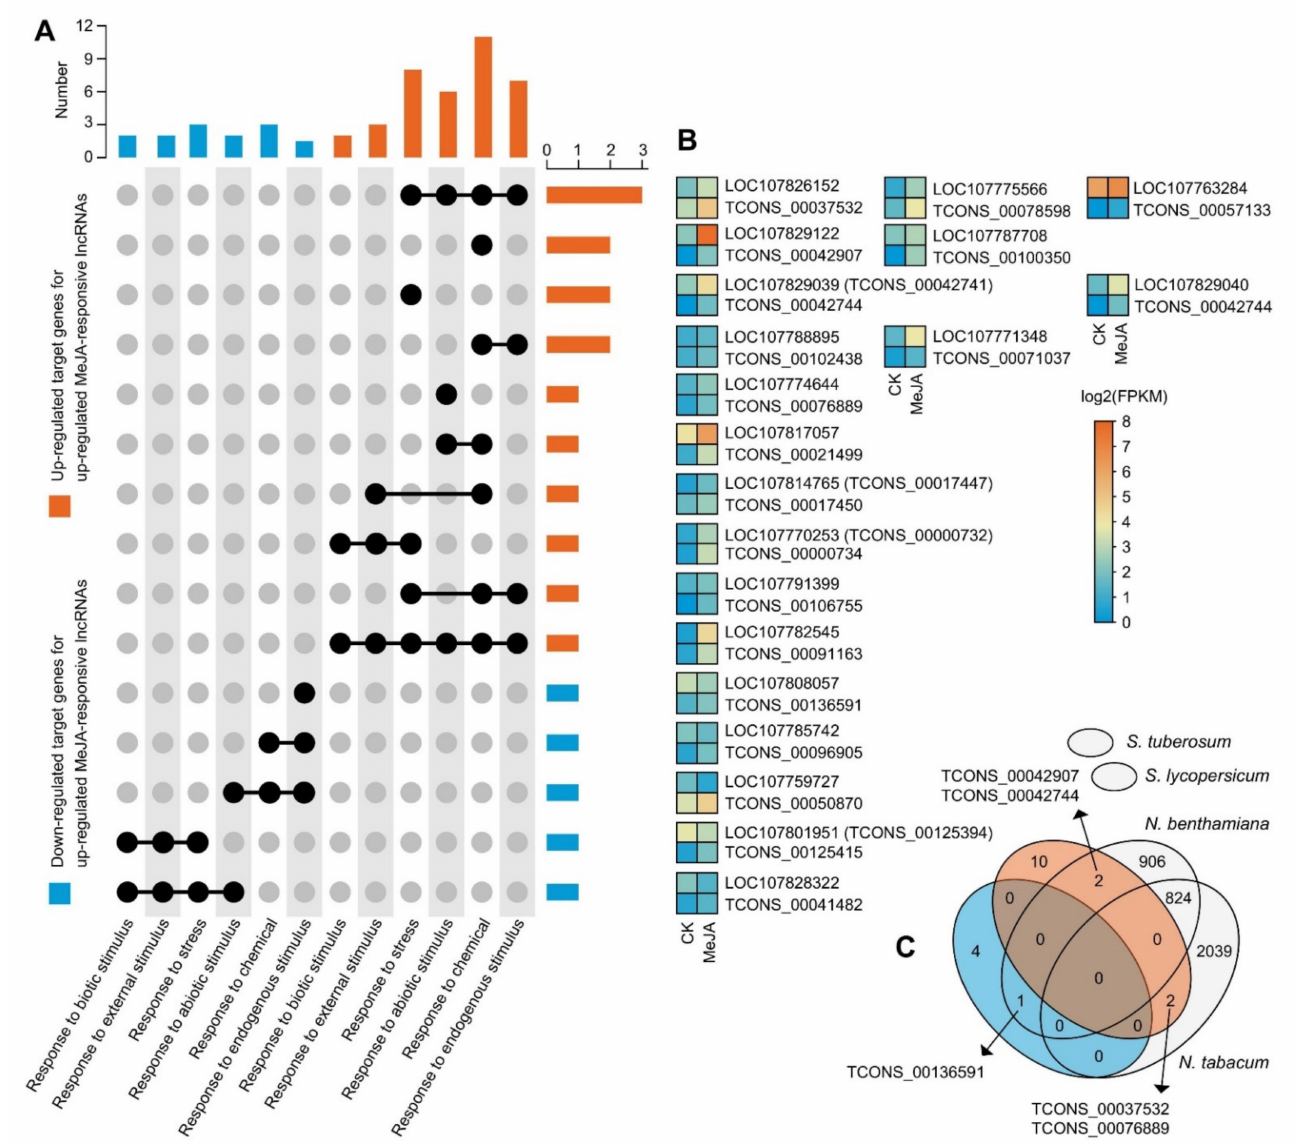
Figure 5. Expression patterns and comparison of cis -target genes of MeJA-responsive lncRNAs associated with responsiveness to diverse stimuli. ( A ) Comparison of plant response functions of up- or downregulated target genes of upregulated MeJA-responsive lncRNAs. ( B ) Expression profiles of up- or downregulated target genes and their MeJA-responsive lncRNAs. ( C ) Comparison of homologous upregulated MeJA-responsive lncRNAs with stimulus-response target genes in four Solanaceae